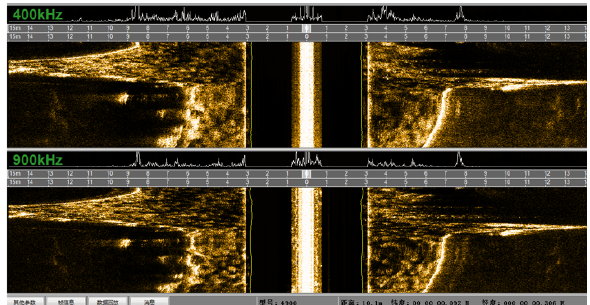
Figure 9. The images of the revetment by side sonar scan.